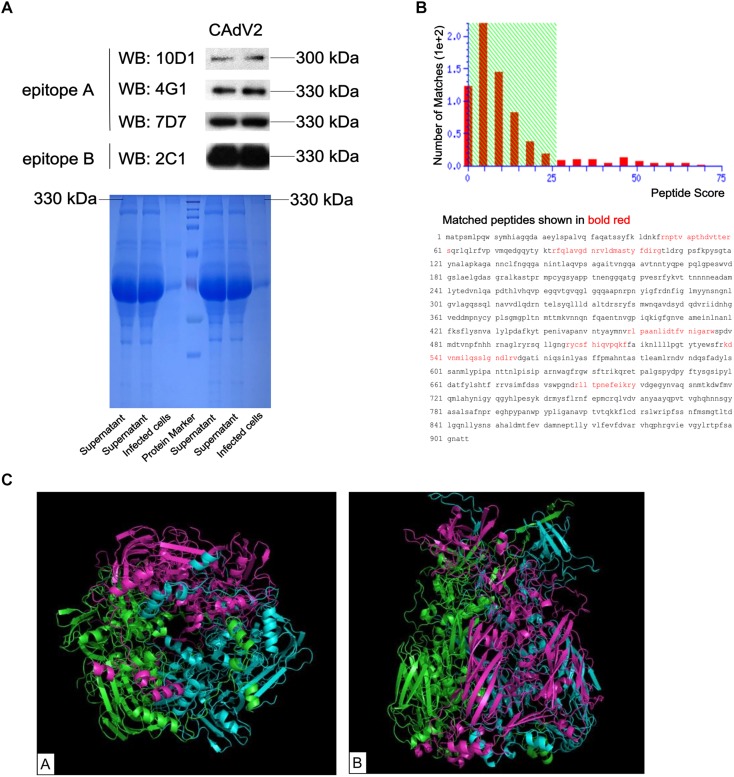
Identification of the CAdV-2 protein that reacted with mAbs. (A) Supernatant from CAdV-2-infected MDCK cells were subjected to western blot analysis using four mAbs (upper); Supernatant and infected cell lysates were subjected to SDS-PAGE (lower). (B) MALDI-TOF-MS results of the proteins identified in bands that reacted with the four mAbs. Protein scores that were greater than 26 were significant (p < 0.05). (C) Predicted 3D structure of the CAdV-2 hexon protein by the SWISS-MODEL online server; A, Bottom view of 3D structure; B, side view of 3D structure; different colors represent each monomer of the trimeric hexon protein.